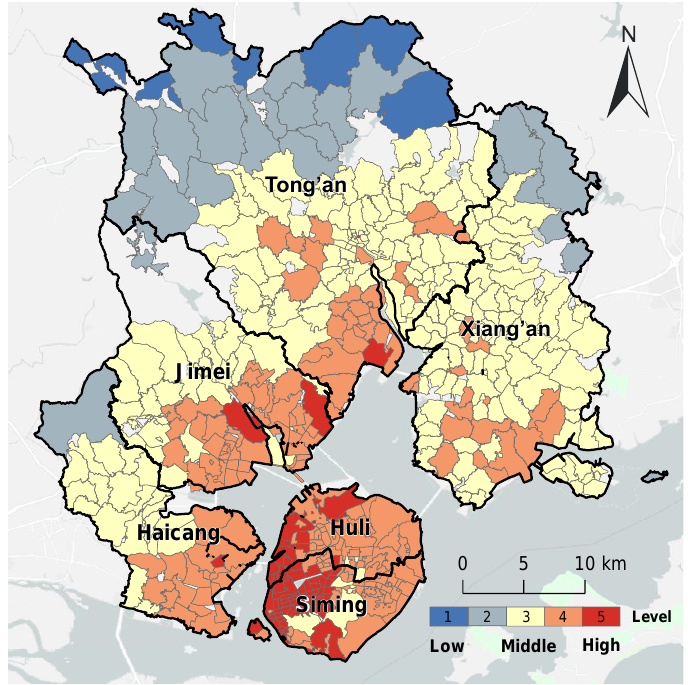
Figure 4. The overall accessibility of urban medical services in Xiamen City.